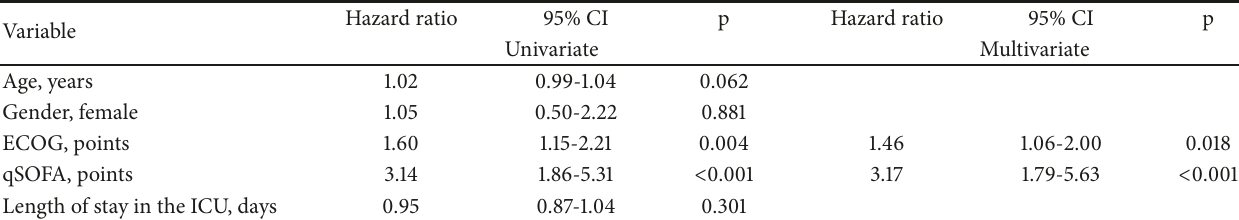
Table 3: Univariable and multivariable analysis of factors associated with in-hospital mortality.